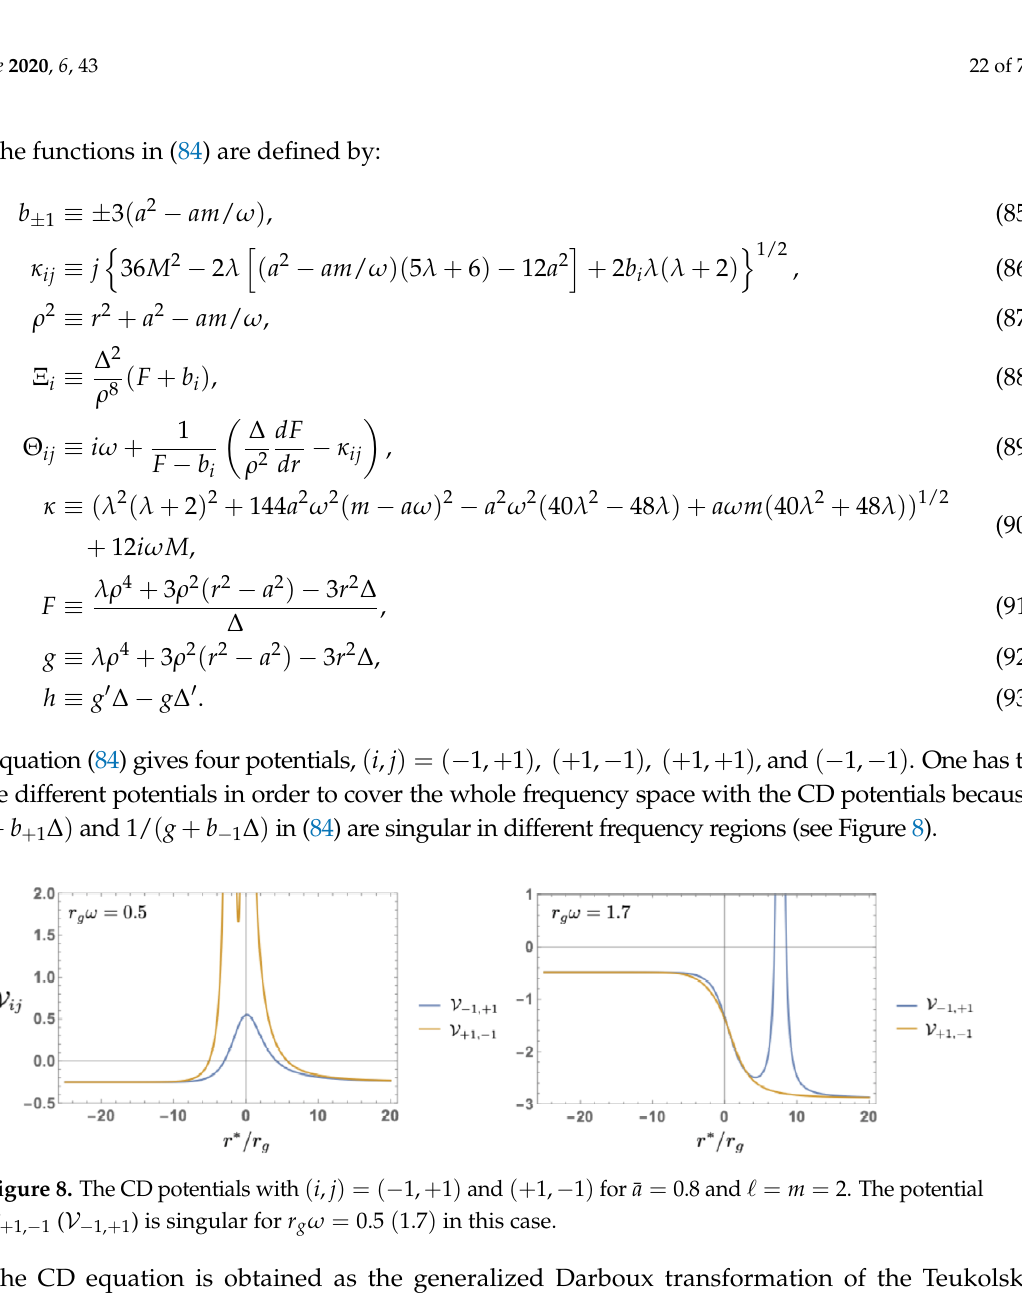
Figure 8. The CD potentials with ( i , j ) = ( ( ) is singular for r g ω = 0.5 ( 1.7 ) in this V + 1, − 1 V − 1, + 1